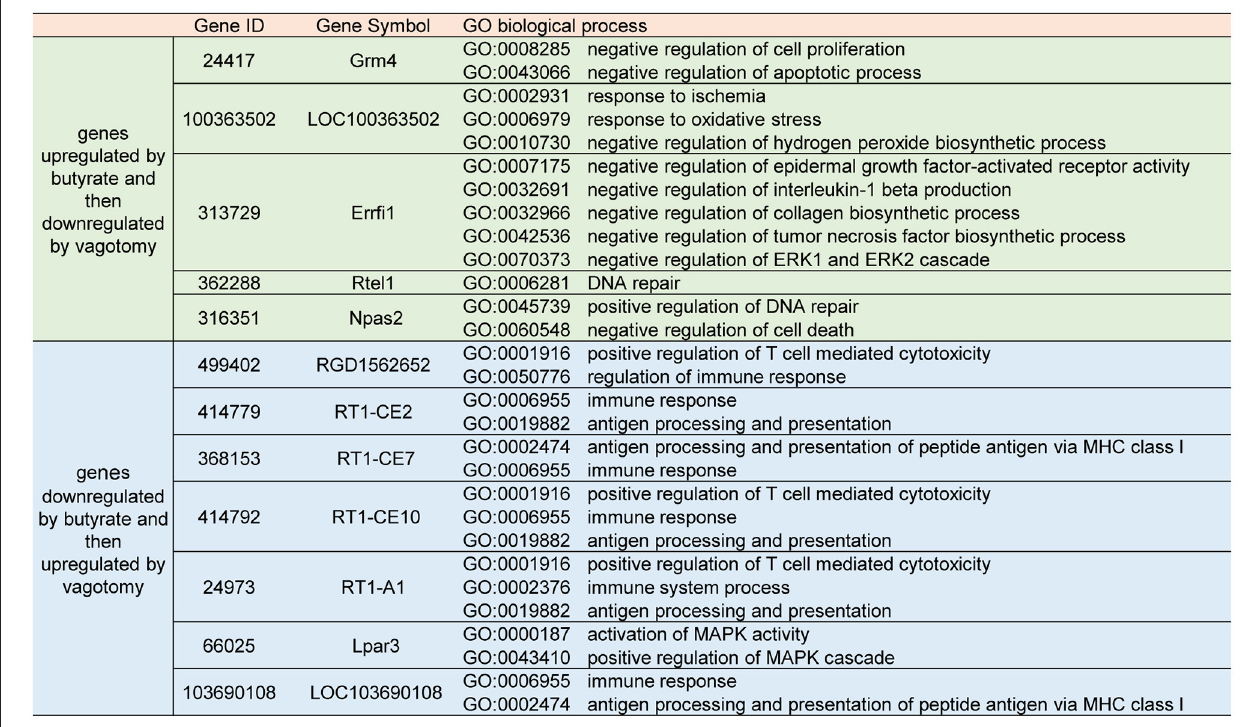
stress and cell apoptosis after I/R. In contrast, the vagotomy group presented significantly higher levels of oxidative stress and apoptosis and decreased Bcl-2 protein expression than the butyrate group ( Figure 2